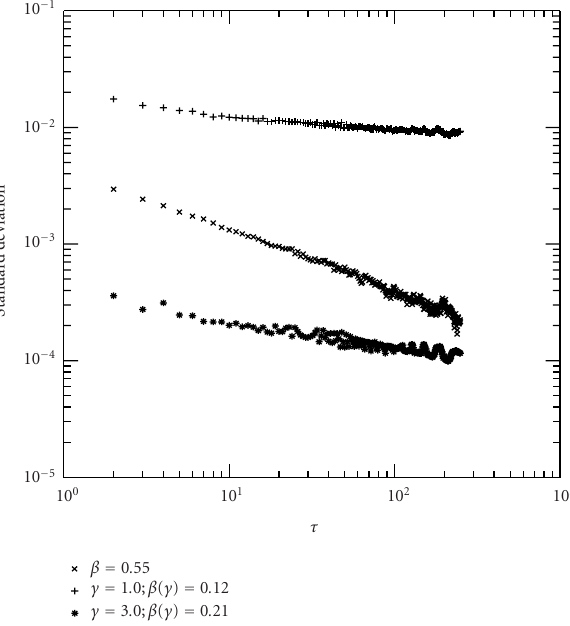
Figure 2.2. Dependence of the standard deviations σ ( τ ) ( × symbol) and σ ( τ , γ ) (+ and ∗ symbols) of the variables ρ ( τ ) and ρ t ( τ , γ ), respectively. σ ( τ , γ ) is displayed for γ = 1 . 0 and γ = 3 . 0 showing the dependence of the slope on the exponent γ .